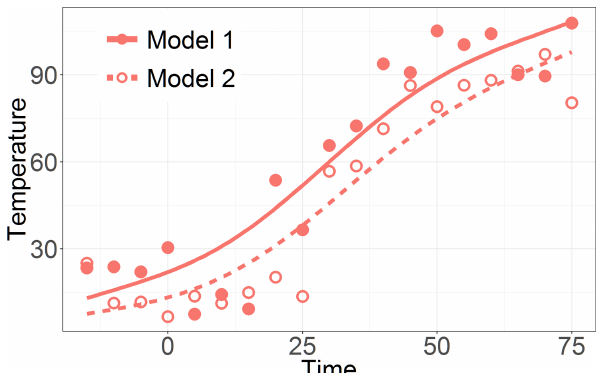
Figure 3. Illustration of the functional data analysis approach for evaluation of time series similarity. The two arbitrarily chosen time series shown here (Model 1 and 2) are evaluated to be quite different when based on d 0 but are similar when based on d 1